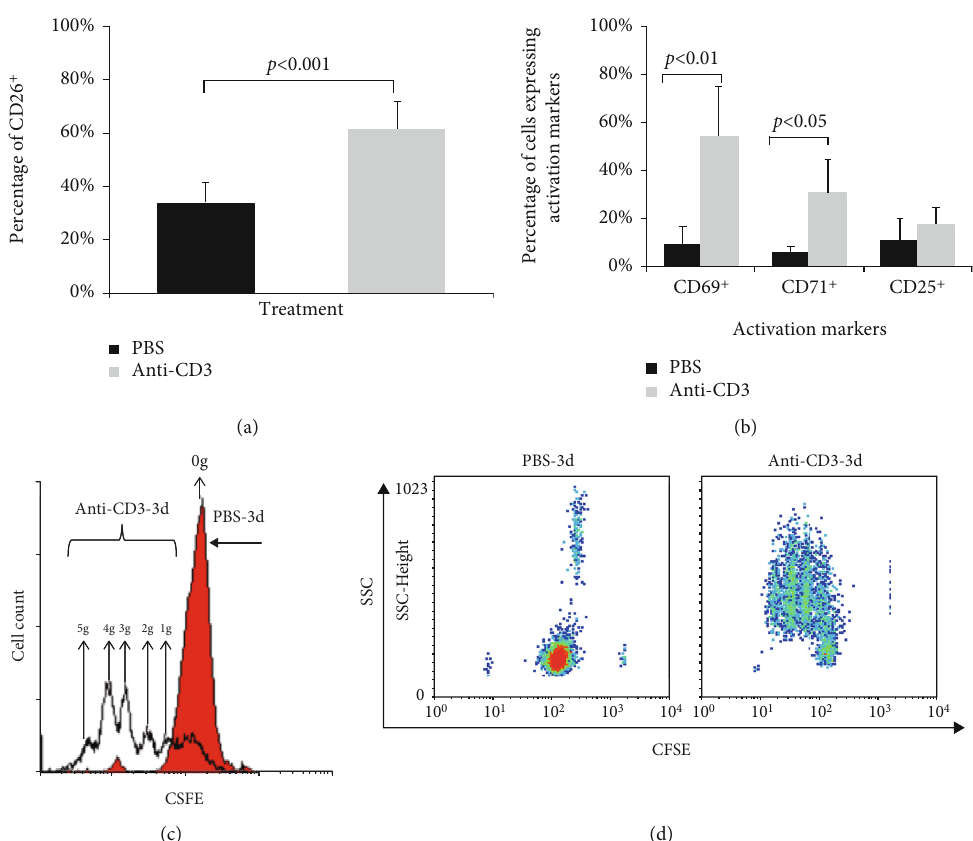
Figure 1: The activation and proliferation of T lymphocyte after stimulation. After 72 h of the stimulation with immobilized anti-CD3 mAb, the activation of lymphocytes was determined by the measurement of the expression of T lymphocyte activation markers (CD69, CD71, CD25, and CD26). The proliferation of lymphocytes was analyzed by CFSE assay. PBS-treated cells were used as controls. (a) Percentages of CD26 + -HPBLs in the control group and the stimulated group. (b) Percentages of CD69 + -, CD71 + -, and CD25 + -HPBLs in the control group and the stimulated group. Data represented mean value ± SD from a minimum of 5 independent experiments with at least 5 healthy donor HPBL samples, and each experiment was repeated more than 3 times. p values were calculated with a chi-square test. (c) Histogram of the proliferated generations of lymphocytes after stimulation by immobilized anti-CD3 mAb (anti-CD3) or only PBS as control (PBS) for three days. The shaded histogram represents the original generation (0g) of the PBS control group at day 3. The hollow histogram indicates the increased 5 generations (1g, 2g, 3g, 4g, and 5g) of the stimulated group three days after stimulation. (d) The dot plots show the proliferated generations of lymphocytes analyzed by fl ow